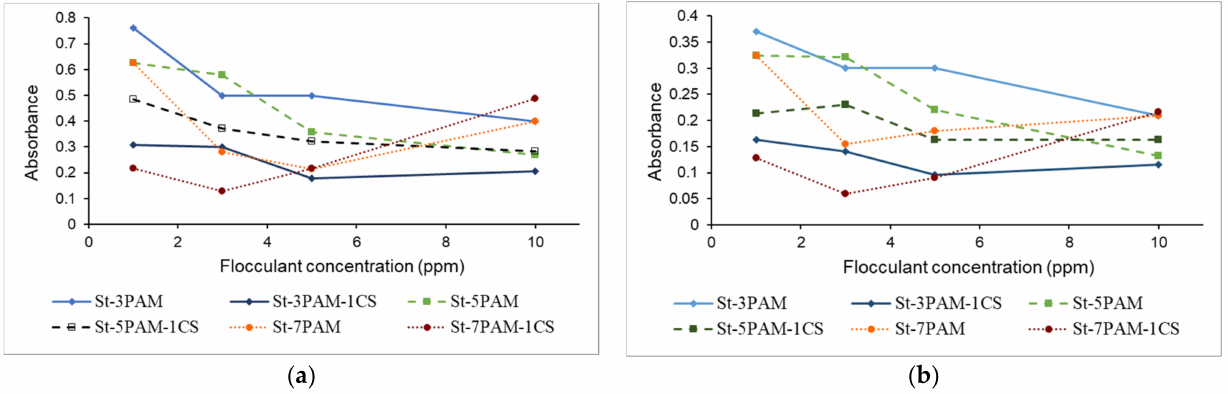
Figure 10. Absorbance for kaolin aqueous suspension as a function of concentration of starch grafted polyacrylamide with different PAM content and their hybrids with 1 wt.% of CSs after: ( a ) 20 min and ( b ) 100 min of flocculation tests duration.